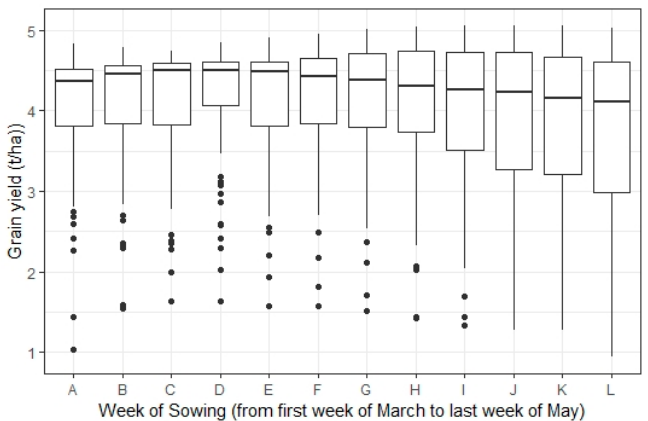
Figure 8. Box plot of grain yield of dual-purpose winter wheat sown at different times (from the first week of March to the last week of May). The box plots show the 25th, 50th, and 75th percentiles.